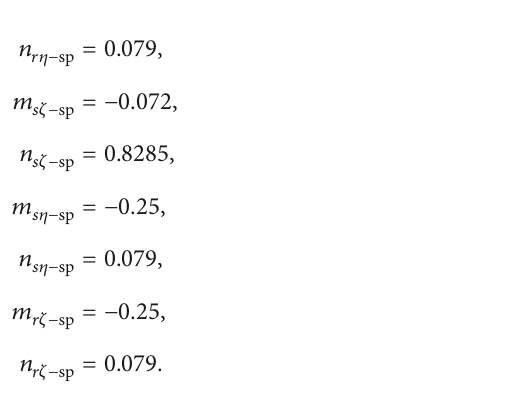
Figure 3: Configurations of the spiral